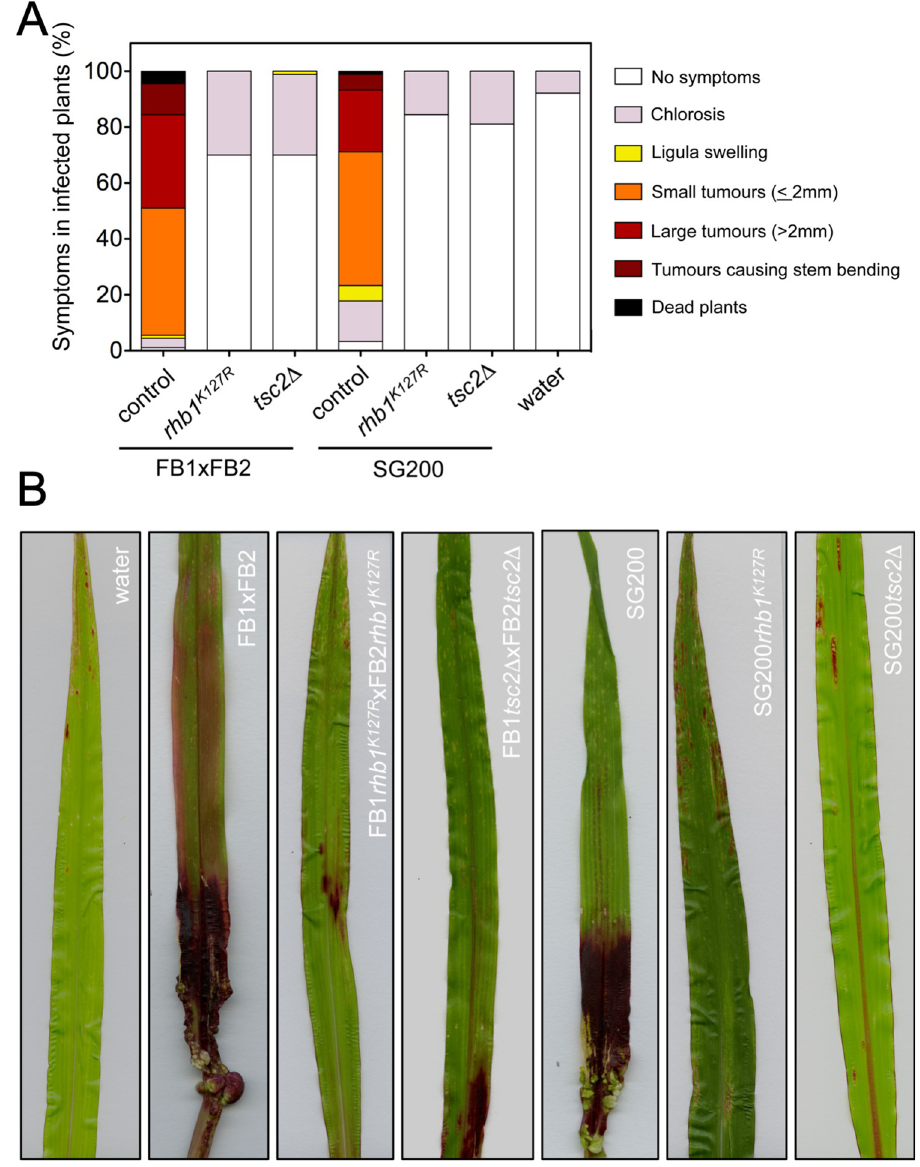
Fig 5. Forced activation of Rheb resulted in avirulence. (A) Graph showing disease symptoms caused by wild-type and mutant strains cross. The symptoms were scored 14 days after infection. Three independent experiments were carried out, and the average values are expressed as a percentage of the total number of infected plants (n: 30 plants in each experiment). (B) Representative leaves 14 days after infection with the indicated